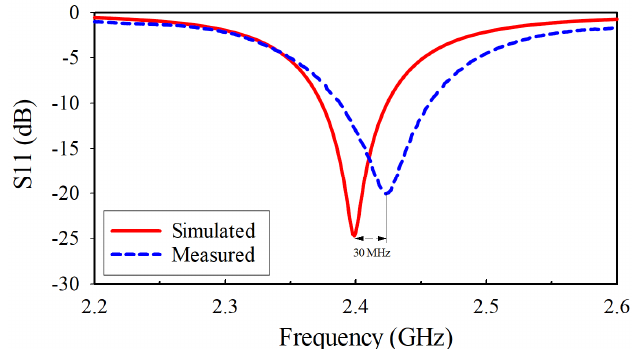
Figure 4. S 11 curve of direct ink-printed antenna.